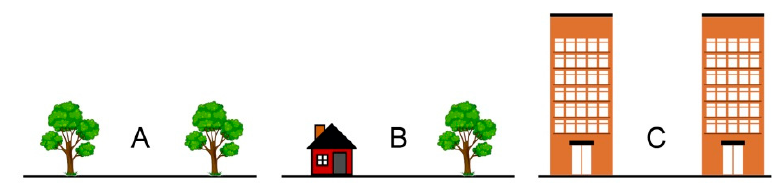
Figure 3. Experimental scenarios.